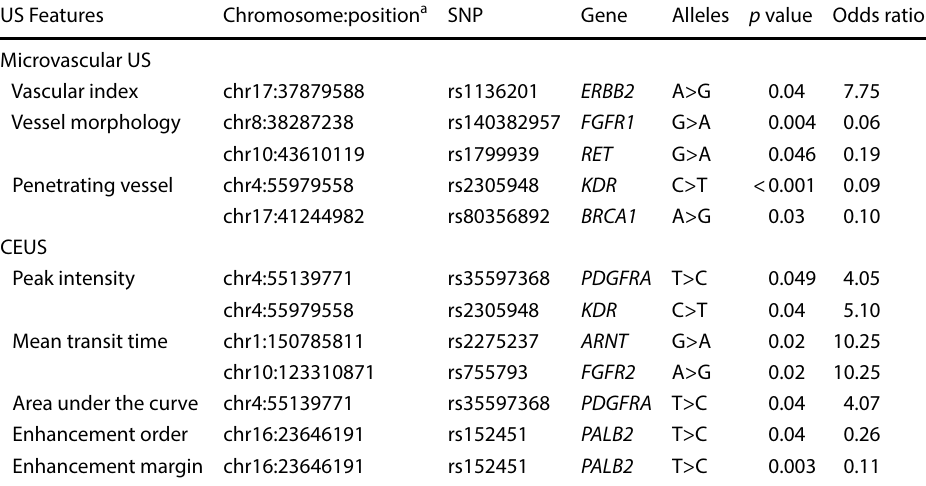
Table 3 Association between vascular US imaging features and genomic